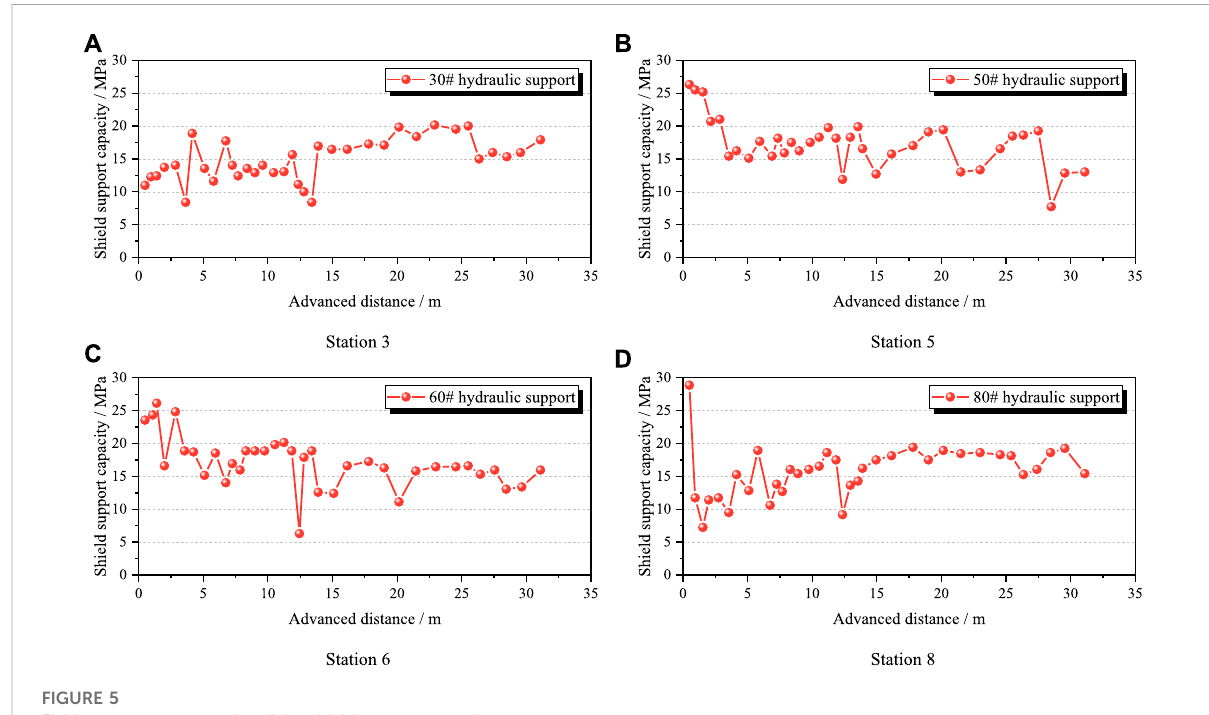
FIGURE 5 Field measurement results of the shield support capacity.